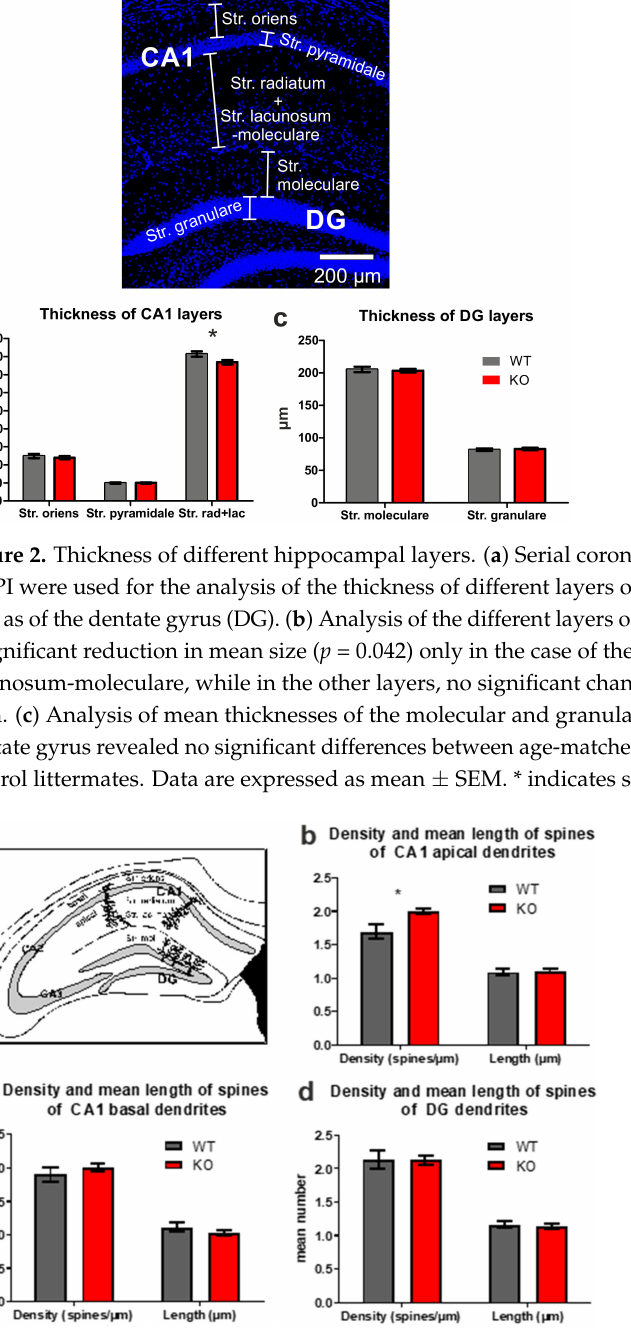
Figure 3. Analysis of dendritic spines. ( a ) Schematic drawing of a hippocampal section indicating the positions of the apical and basal dendrites of CA1 pyramidal neurons and of the dendrites of the granule cells of the upper leaf of the DG that extends into the molecular layer. ( b ) Analysis of dendritic spines of the apical dendrites of Area CA1 revealed that the mean length of dendritic spines was not different between FTSJ1-deficient mice and the respective controls, but that spine densities were significantly increased in FTSJ1-deficient mice. ( c ) Analysis of dendritic spines on the basal dendrites of CA1 pyramidal neurons revealed no differences in either mean spine densities or mean spine length. ( d ) Dendritic spines in the molecular layer of the dentate gyrus did not differ between FTSJ1 knockout and control mice. Data are shown as mean ± SEM. * indicates significant differences ( p <